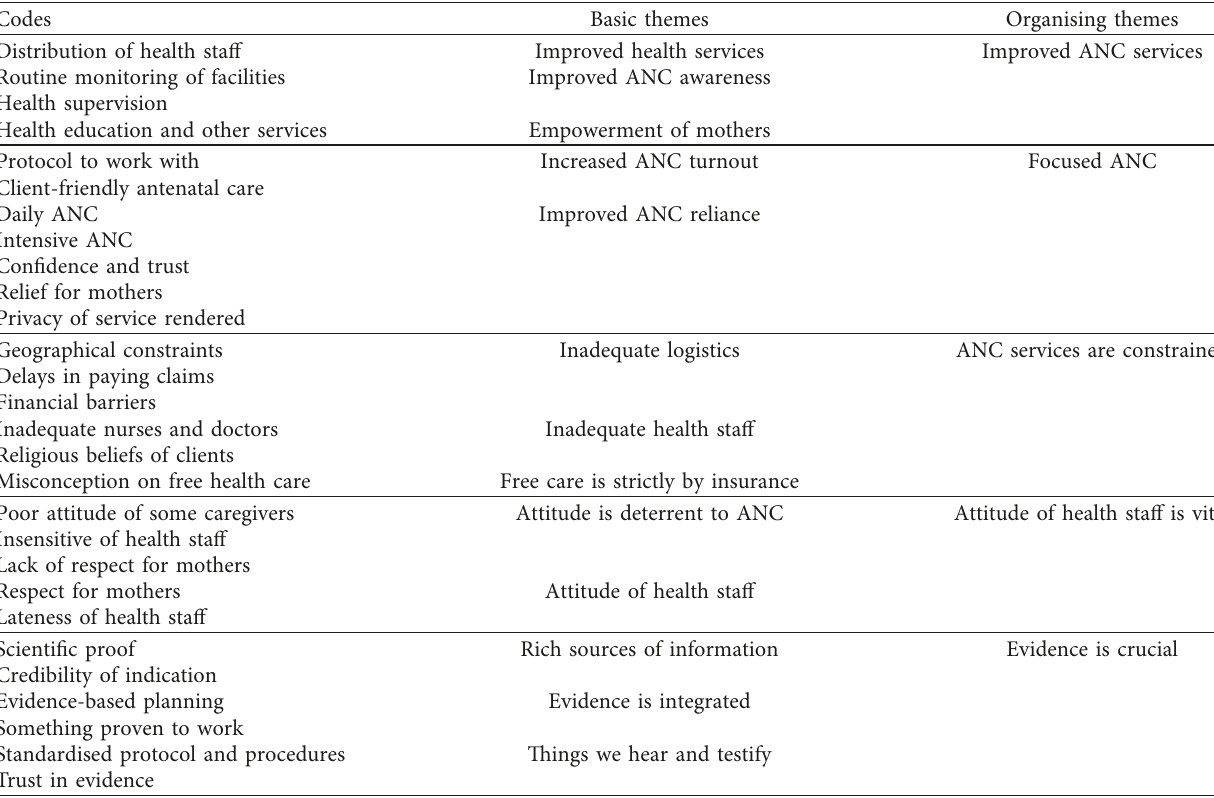
Table 1: Global theme: pathways to evidence-based antenatal